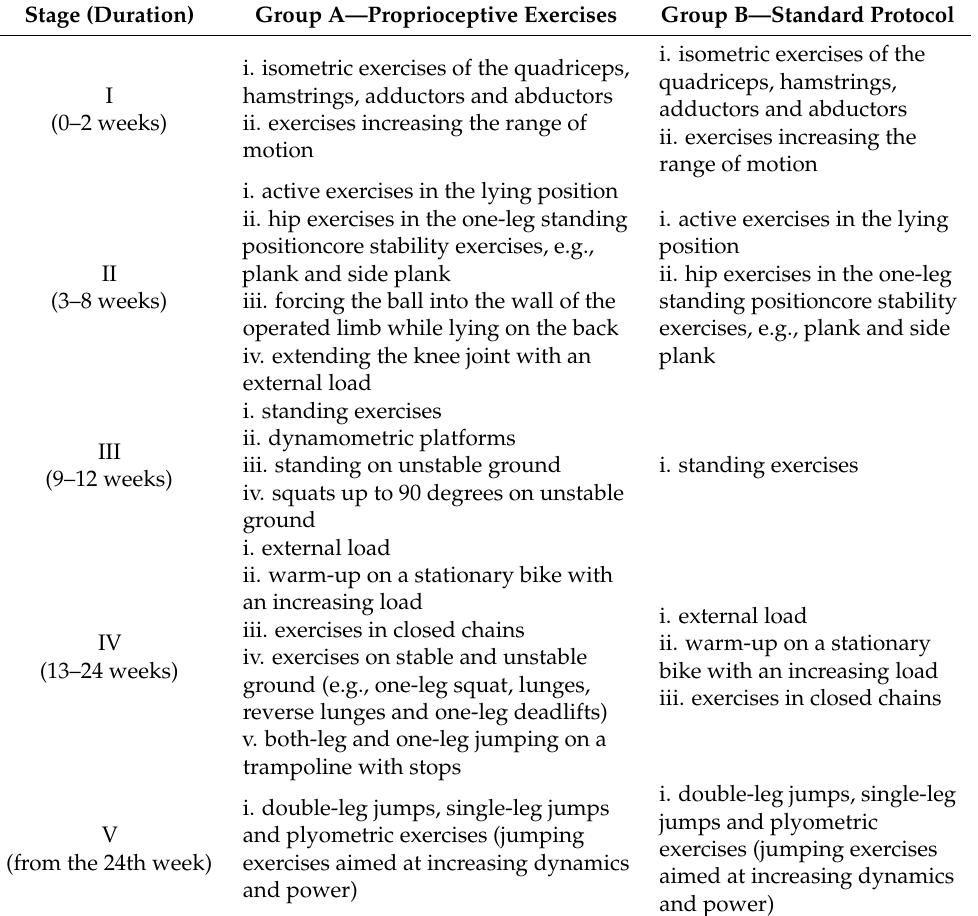
Table 1. Summary of the rehabilitation